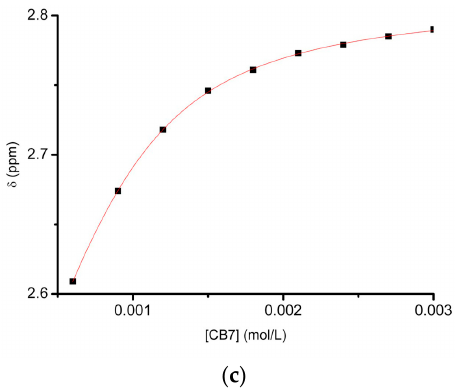
Figure 4. Absorbance spectra along with the corresponding fitting curves of FT@CB[7] ( a ) and NT@CB[7] ( b ) as monitored by UV-visible spectrometry. Fitting curve of H(5) proton NMR resonance of CT against the concentration of CB[7] in D 2 O at 25 ° C ( c ).